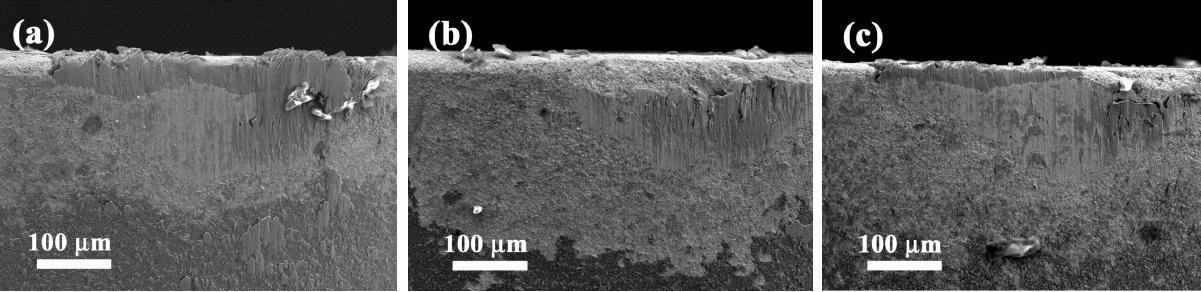
Figure 10. Flank wear patterns of cutting inserts coated with ( a ) TiN, ( b ) TiAlN, and ( c ) (Al 0.34 Cr 0.22 Nb 0.11 Si 0.11 Ti 0.22 ) 50 N 50 after interrupted milling tests against 304 stainless steel with the cutting distance of 900